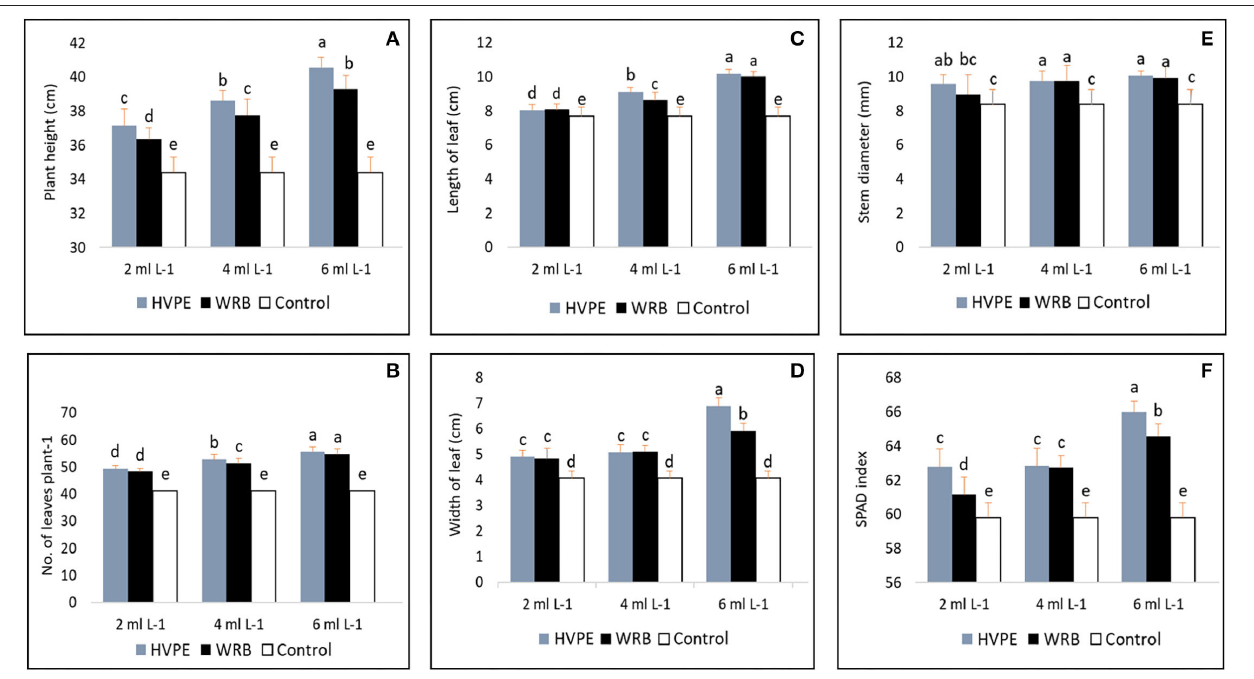
FIGURE 1 | Plant height, number of leaves, length of leaf, the width of leaf, stem diameter, and spad index (A–F) of bell pepper untreated plants (Tr0), treated with 2mL L − 1 (HVPE-1), 4mL L − 1 (HVPE-2), 6mL L − 1 (HVPE-3) of the HVPE. Additionally, with 2mL L − 1 (WRB-1), 4mL L − 1 (WRB-2), 6mL L − 1 (WRB-3) of the WRB. Plant height (A) , Number of leaves plant − 1 (B) , Length of the leaf (C) , Width of the leaf (D) , Stem Diameter (E) , SPAD Index (F)